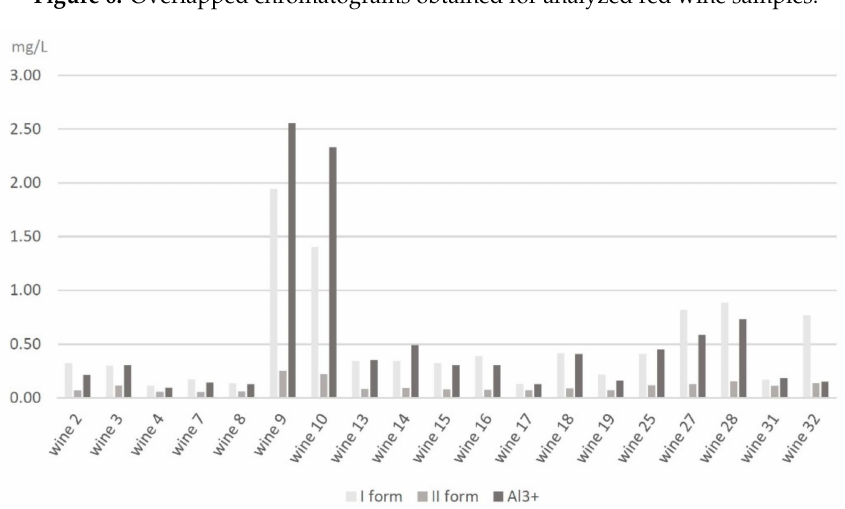
Figure 7. Comparison of contribution all forms of aluminum in white